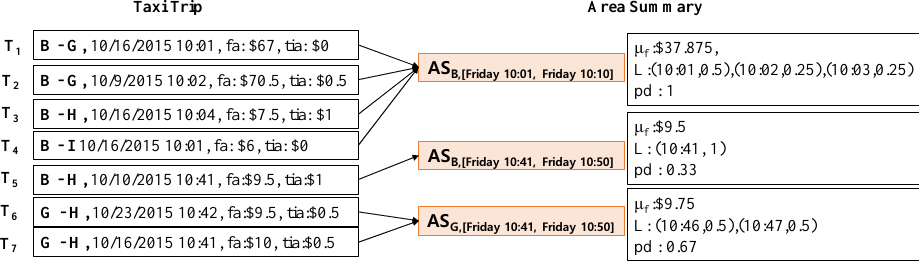
Figure 7. Computing an area